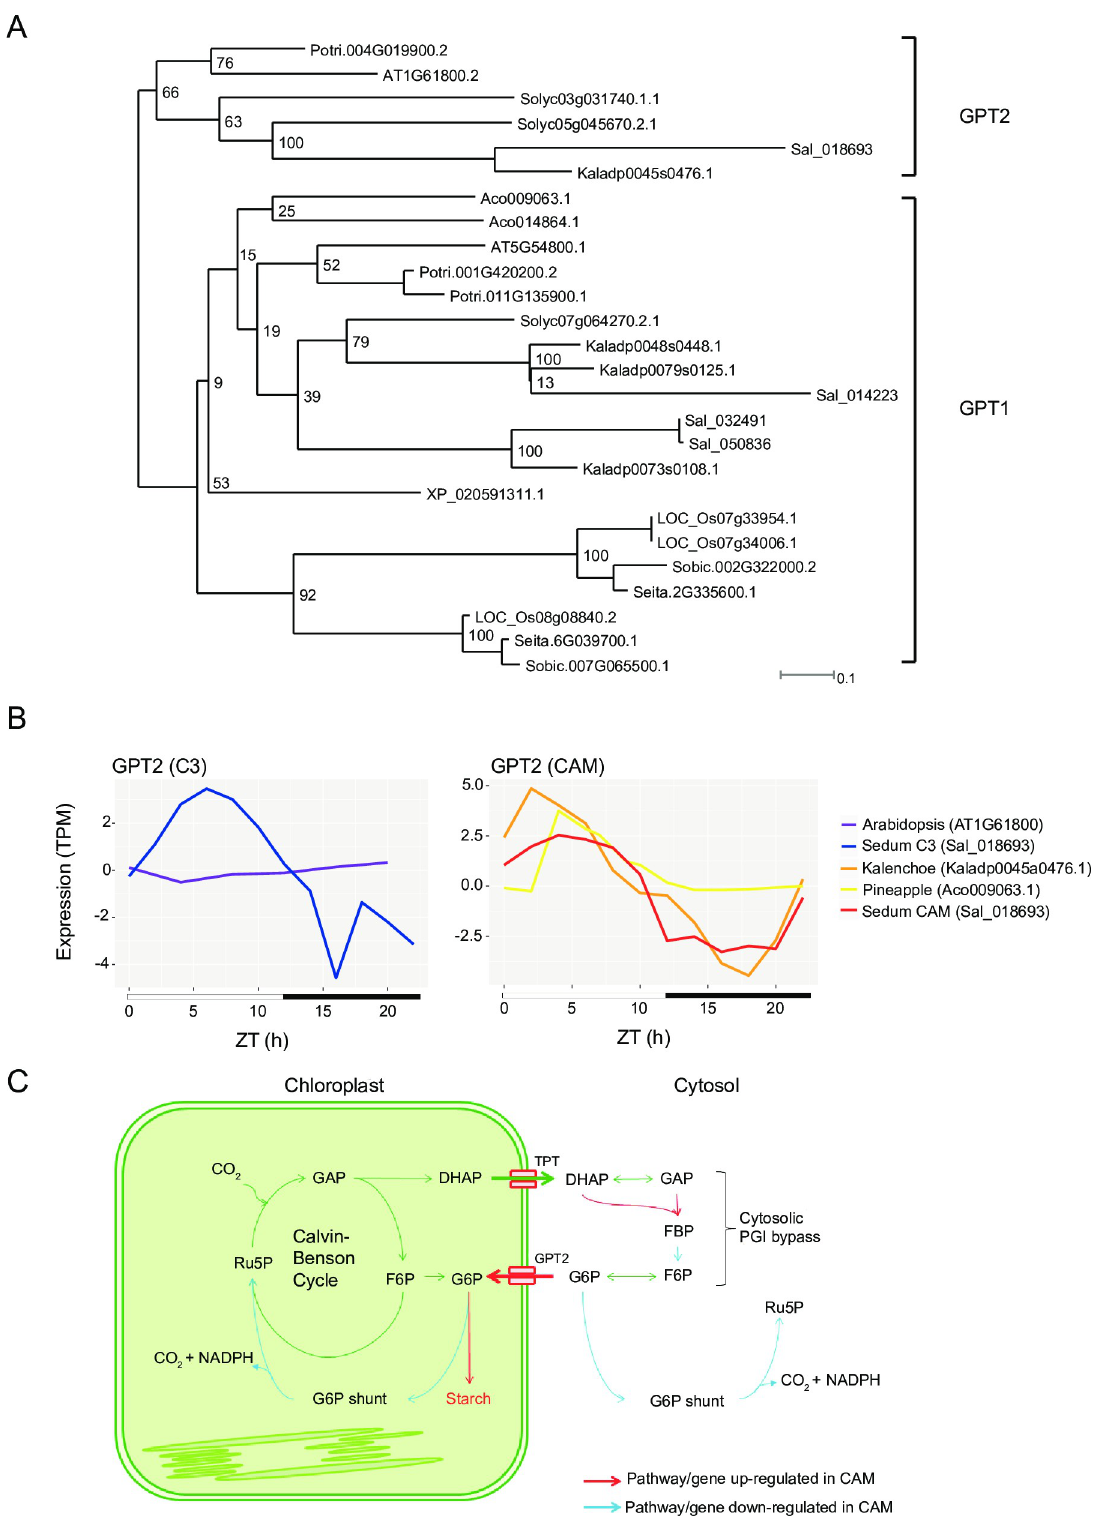
Fig 8. Conserved expression of glucose 6-phosphate transporter 2 ( GPT2 ) across CAM plants and regulation of starch metabolism in S . album . (A) Maximum likelihood phylogeny of GPT1 and GPT2 among 10 species. (B) Transcript expression of GPT2 in C3 timecourses (Arabidopsis and well-watered S . album ), CAM-cycling (drought induced S . album ) and constitutive CAM (pineapple and